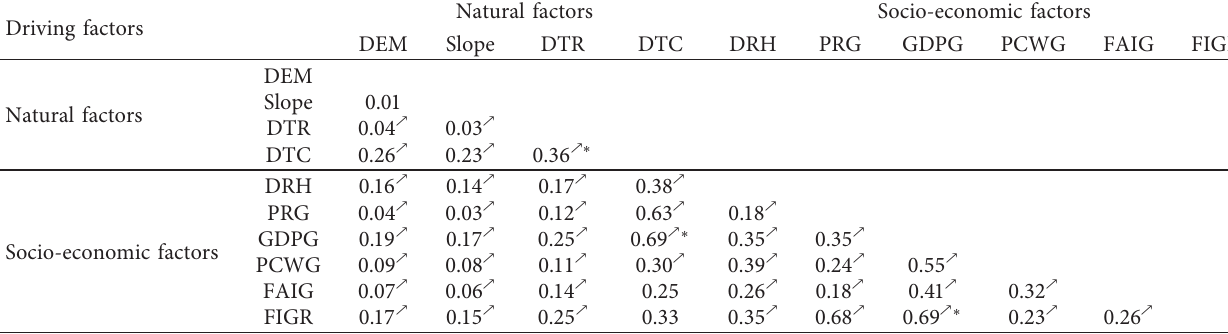
Table 7: Interaction of different factor pairs on urban expansion landscape pattern during 2008–2015. Natural factors Driving factors Natural